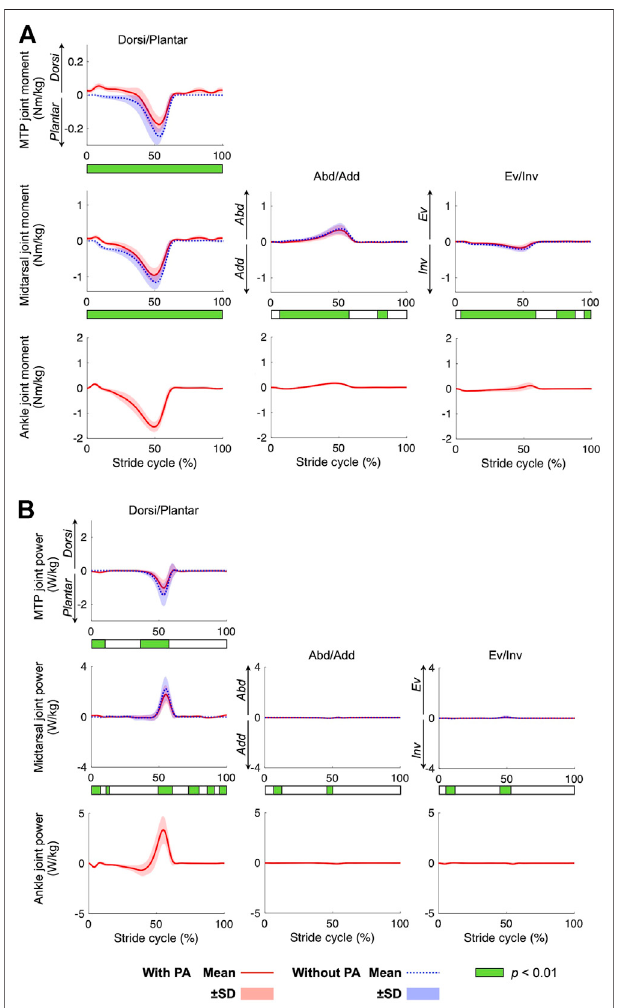
FIGURE 6 | Comparison of the joint moment (A) and joint power (B) pro fi les between models with (blue) and without the plantar aponeurosis